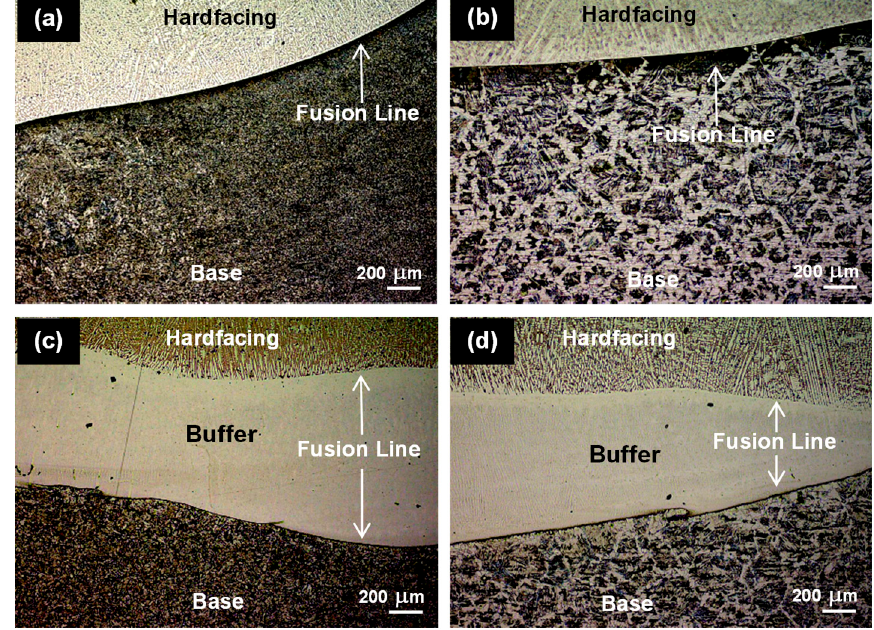
Figure 3. Microscopic result of hardfacing welded specimens: ( a ) S1, ( b ) S2, ( c ) H1, and ( d ) H2.